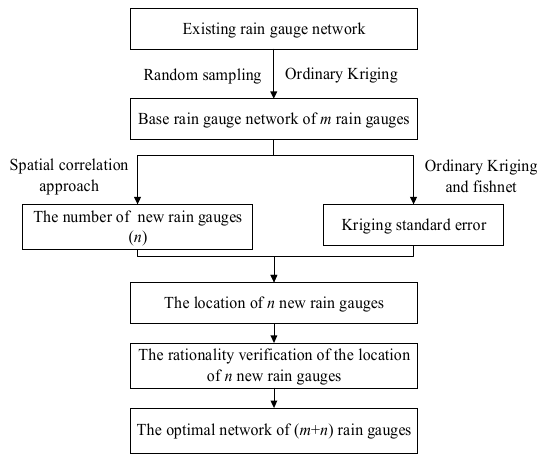
Figure 2. Framework for optimizing the network of rain gauges.